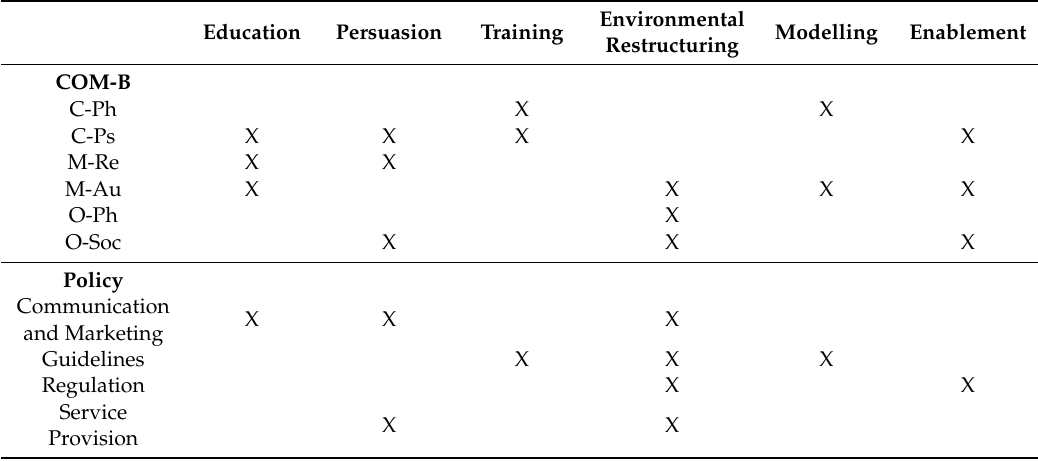
Table 1. Link between components of Capability–Opportunity–Motivation-Behaviour (COM-B), Policy and Move-It intervention